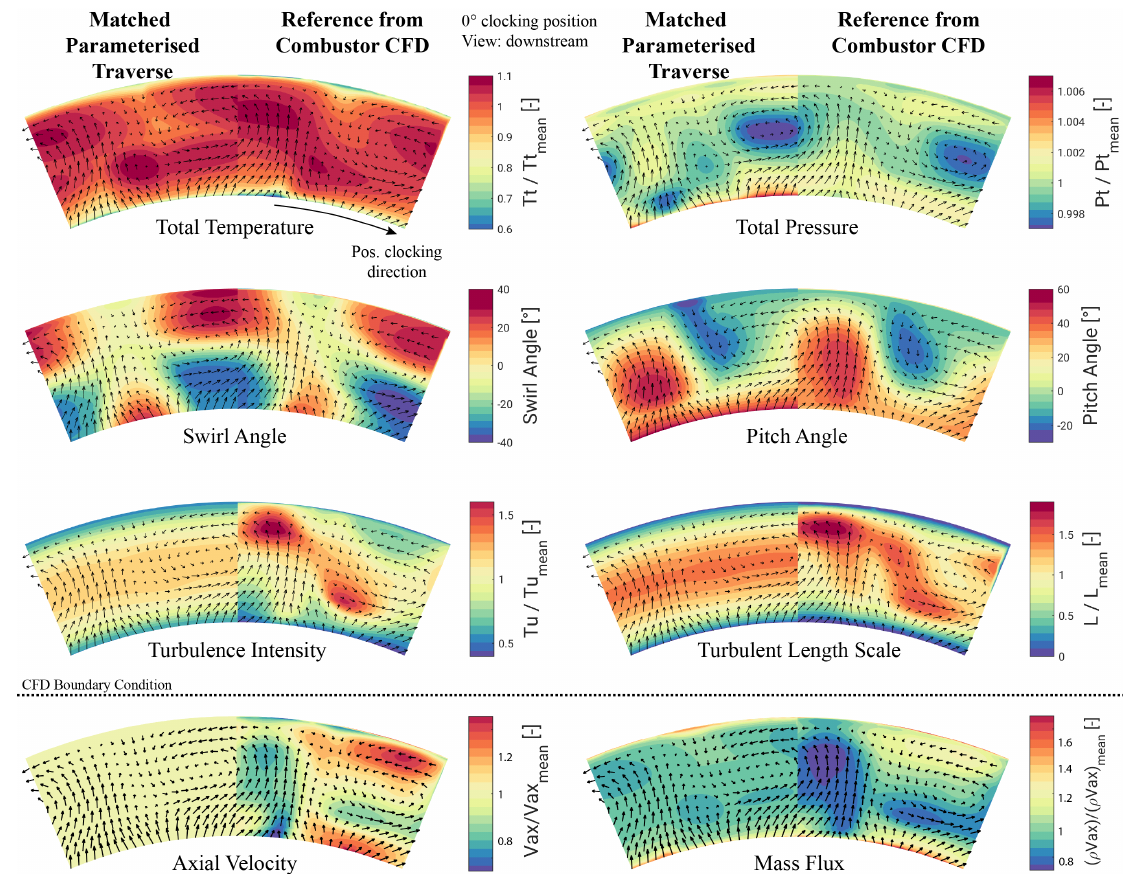
Figure 8. Comparison of parameterisaton with a benchmark combustor CFD